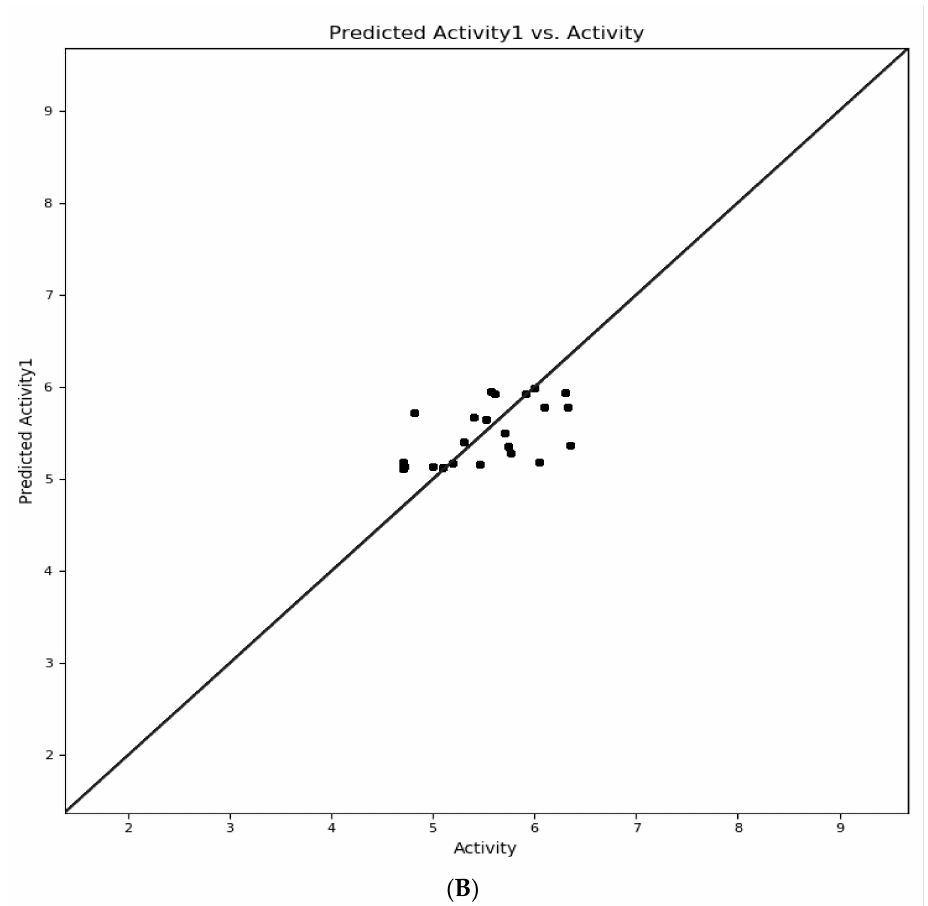
Figure 4. ( A ) Percent screen plot; ( B ) ROC